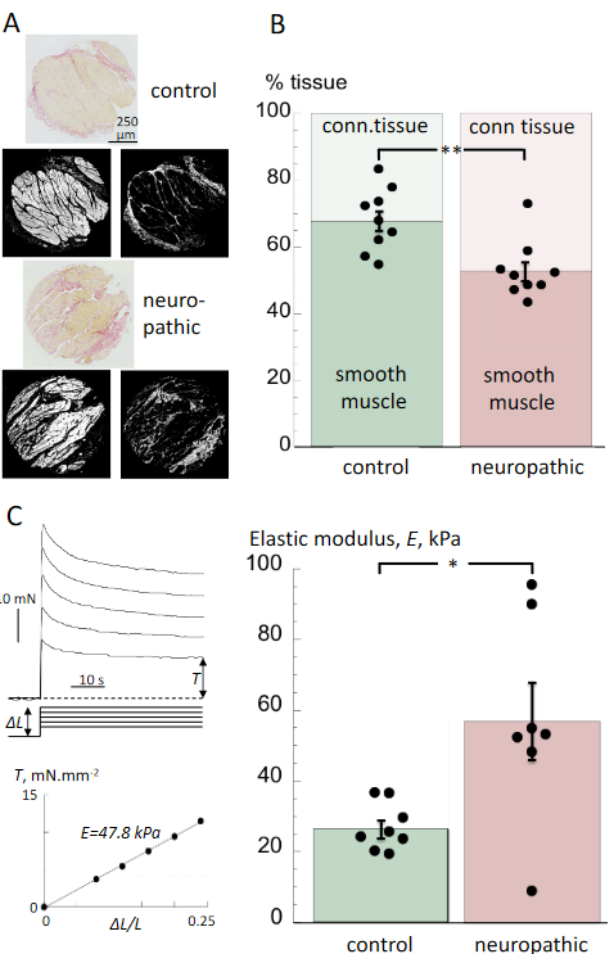
Figure 2. Histological and biomechanical properties of detrusor from neuropathic and control bladders ( A ): Verhoeff van Gieson stained sections of tissue from control (upper trio) and neuropathic (lower trio) bladders. Shown below each primary section (yellow/orange: smooth muscle: red; collagen) are grey scale images of the yellow/orange (left) and red (right) areas obtained from ImageJ files. ( B ): Percentages of detrusor and connective tissue in samples from neuropathic and control bladders (mean ± SEM, n = 9,9 neuropathic vs. control; ** p < 0.01). Dot plots show the percentages of smooth muscle ( C ): Sample traces (left) of tension values upon rapid, sustained stretches for estimation of the elastic modulus. The asymptotic tension values, T , were recorded for a series of sustained strain changes, ranging from ∆ L = 0.08–0.24 in equal increments. The plot below shows the relationship between T and ∆ L / L with the slope equal to the elastic constant, E (see Methods for more details). Bar chart with dot plots of values of E from neuropathic and control bladders (mean ± SEM, n = 7,8); * p < 0.05 neuropathic vs. control. Expression of key proteins in cell turnover and fibrosis was measured from high- power immunofluorescent images ( × 20, upper and × 63, lower; Figure 3A) of control and neuropathic bladders; three sections from each sample were imaged. DAPI counts, as a nuclear stain and indicative of cell numbers, were not different between the two groups (9.73 ± 1.32 × 10 8 vs. 9.79 ± 2.05 × 10 8 pixels per section; n = 9,5; Figure 3B), indicating that any alterations to other labels were not due to different numbers of cells. MMP7 protein expression was not different in the two groups, nor was it for cyclin D1 or β -catenin; however, there were significantly ( p < 0.01) fewer counts of c-Myc expression in samples from the neuropathic